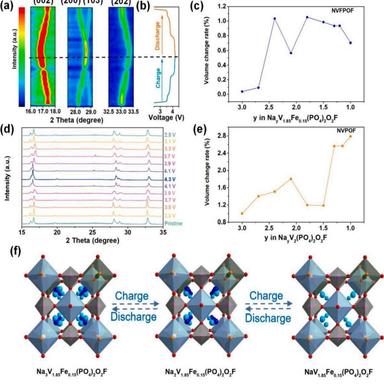
(a) In-situ X-ray diffraction pattern changes; (b) GCD of the first cycle; (c) The volume change rate of NayV1.85Fe0.15(PO4)2O2F cathode during charging; (d) Ex-situ X-ray diffraction pattern changes; (e) The volume change rate of NayV2(PO4)2O2F cathode during charging; (f) A schematic diagram of the crystal structure transition diagram of Na3V1.85Fe0.15(PO4)2O2F cathode.